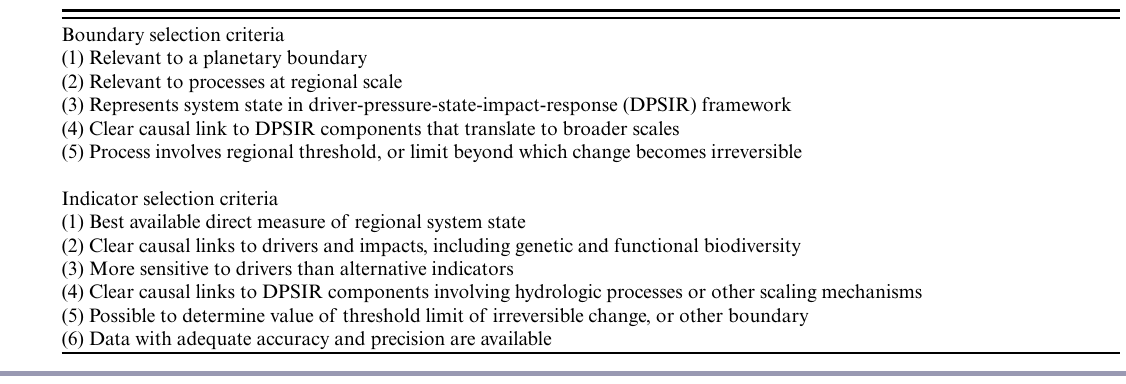
Table 1 . Ordered selection criteria for regional boundaries and state indicator variables. Candidate boundary and indicator variables were compared with criteria in ascending order. Variables that did not meet a criterion were discarded, and evaluation proceeded with alternative